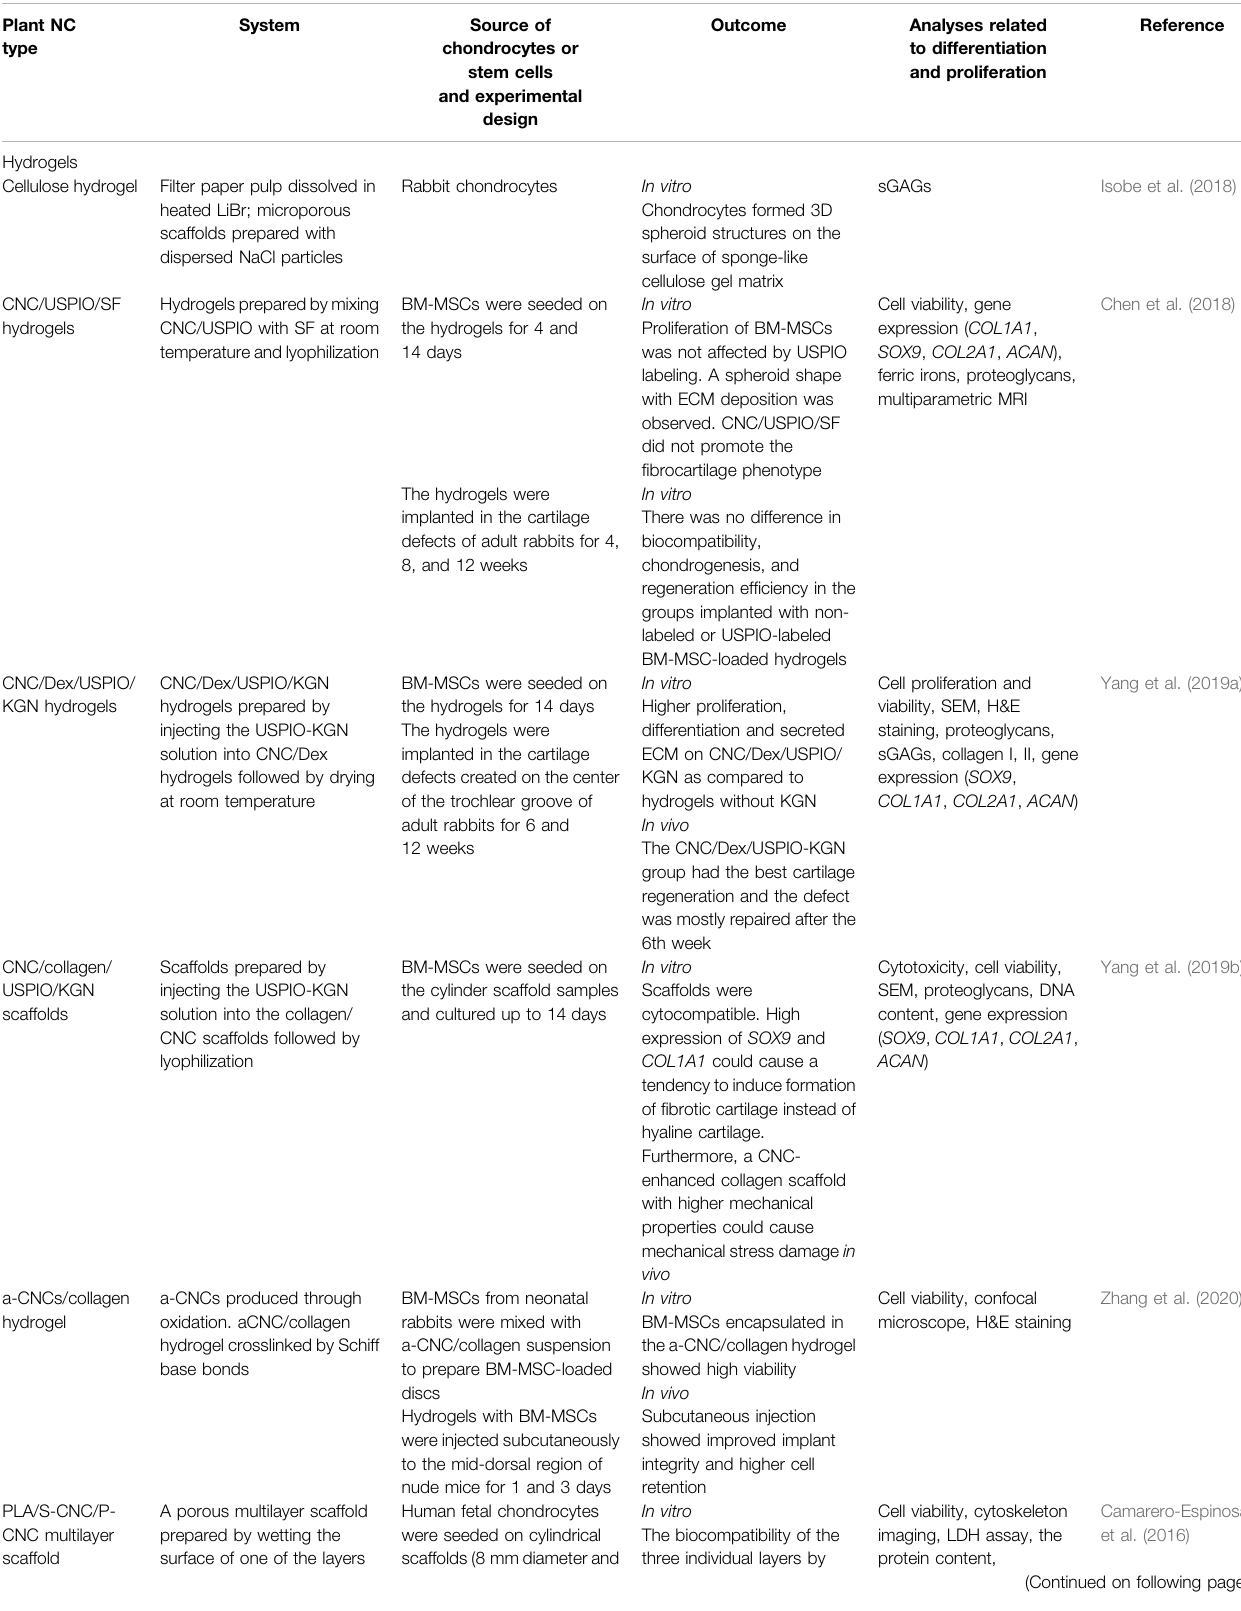
TABLE 1 | Plant-derived NC applied to cartilage tissue